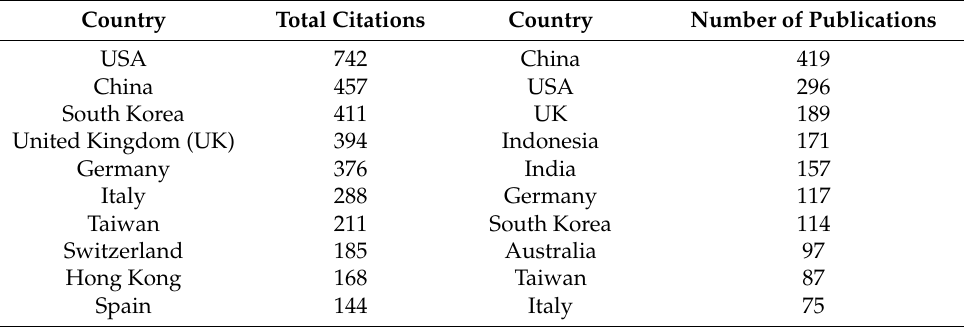
Table 4. Core Countries in Terms of Number and Citations.